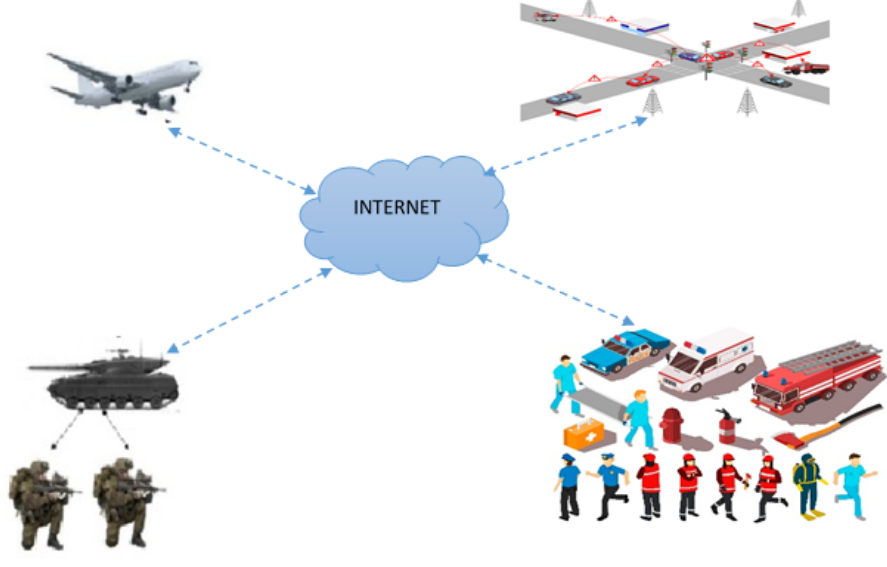
Figure 1. Examples of MANETs communication